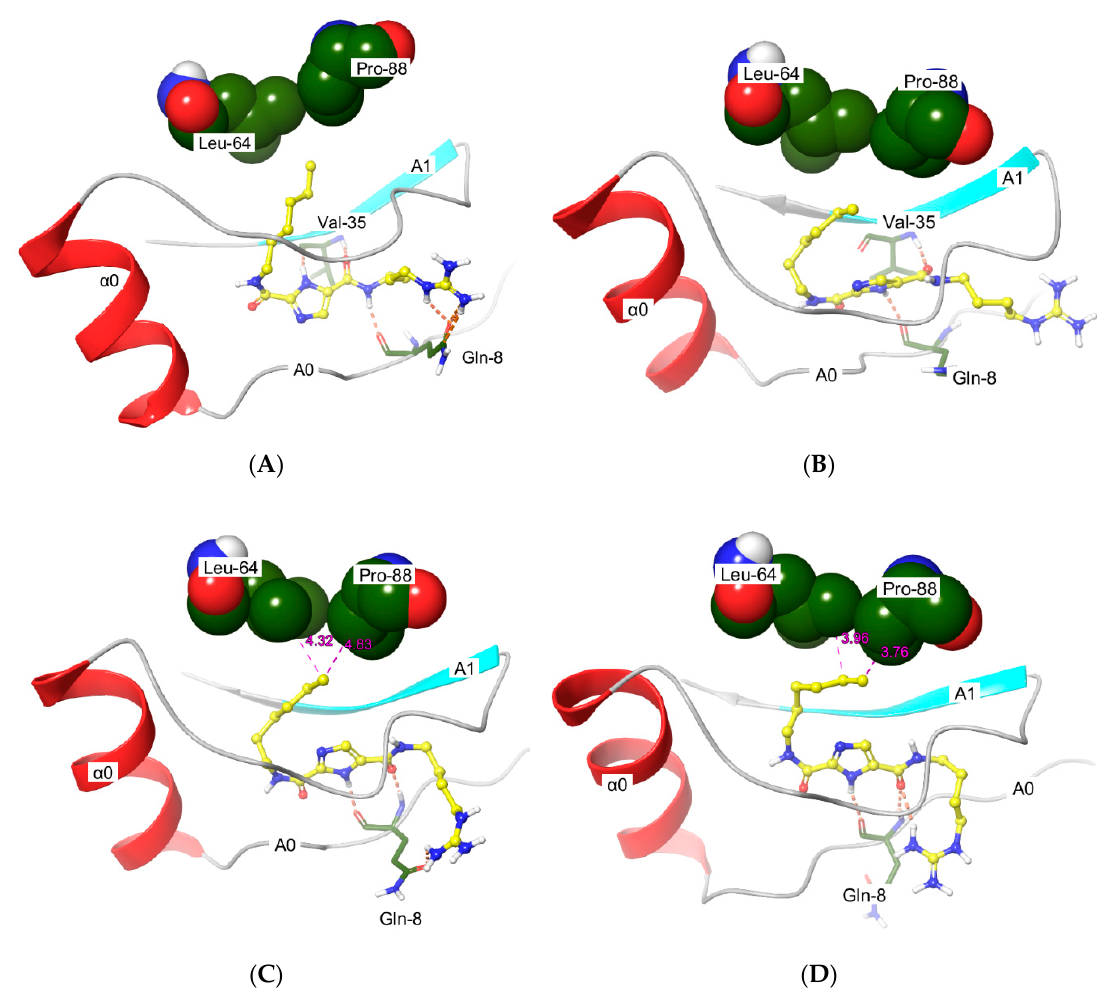
Figure 8. Interactions of MOC-24 (yellow) with the most important residues (green) at the significant time frames. ( A ) At the start of the simulations, ( B ) at 10 ns when protein stability started, ( C ) at 13.4 ns when imidazole-2,5-diamide completely flipped, and ( D ) at the end of the molecular dynamics (MD) simulation. Hydrogen bonds are dashed lines in orange, valid van der Waals (VdW) interaction distances are shown as dashed lines, and numerical values are displayed in angstroms with a magenta color.